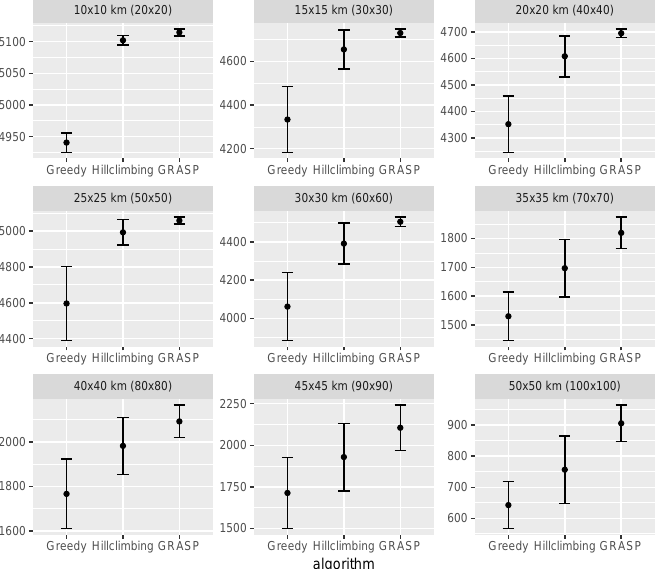
Figure 9. Mean objective values with standard deviation from 30 runs across the 9 instances and 3